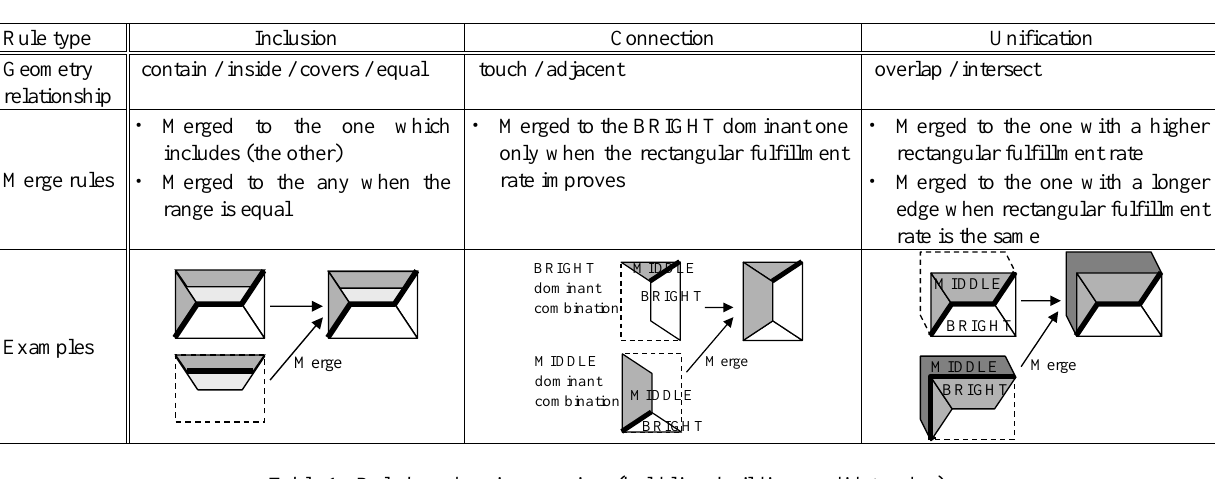
Table 1. Rule-based region merging (bold line=building candidate edge)